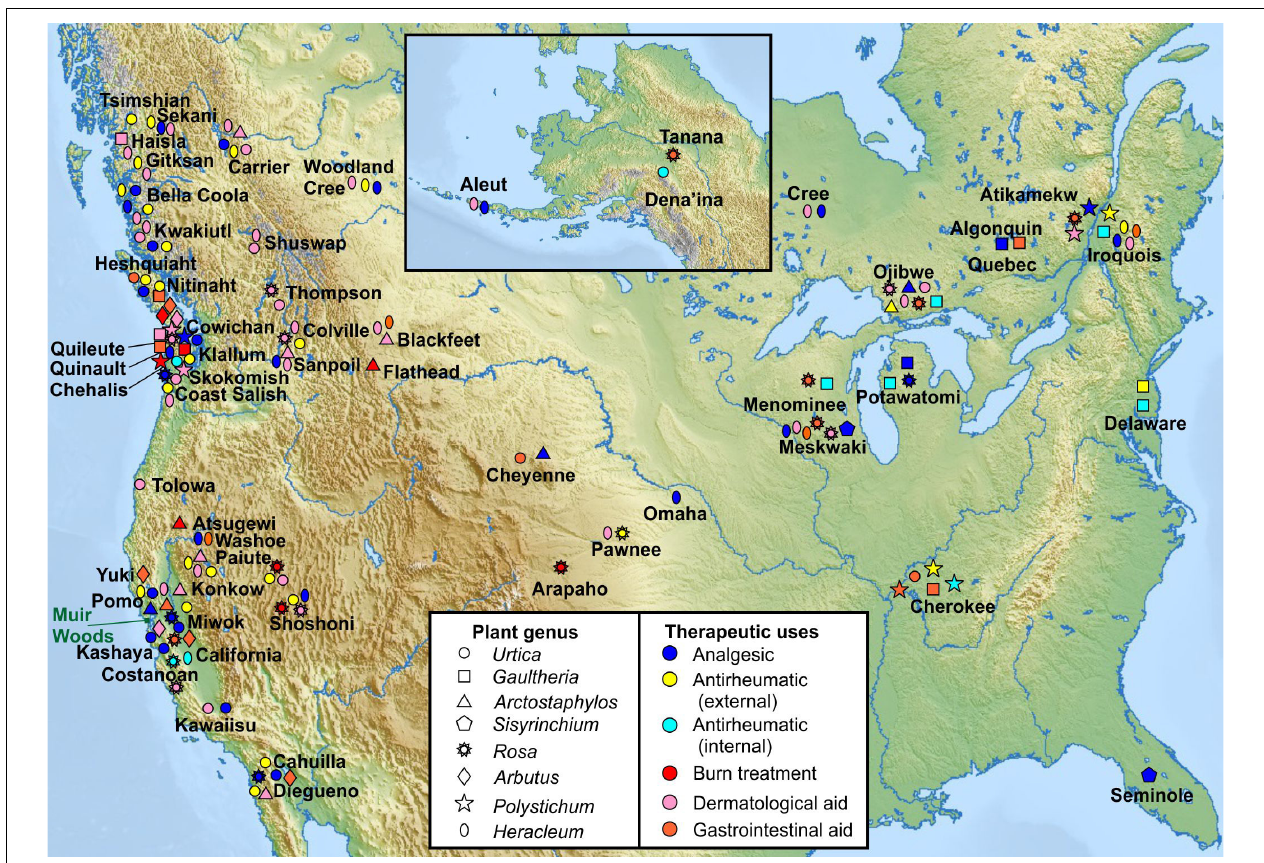
FIGURE 2 | Traditional medicinal usage of KCNQ2/3-activating plants. Geographical and tribal traditional medicinal usage of 8 native plant extract “hits” from KCNQ2/3 screening, categorized by plant genus as reported in Moerman (2009) to permit comparison of indigenous medicinal use of closely related plant species native to geographically distinct regions. Approximate locations of Native American tribes are indicated by plant usage symbols and tribe names. Note that many of the tribal lands constitute much larger areas than depicted by single labels or symbols. Muir Woods location indicated by green rectangle. Upper inset: Alaska and neighboring region (Tribal location sources in Supplementary Material